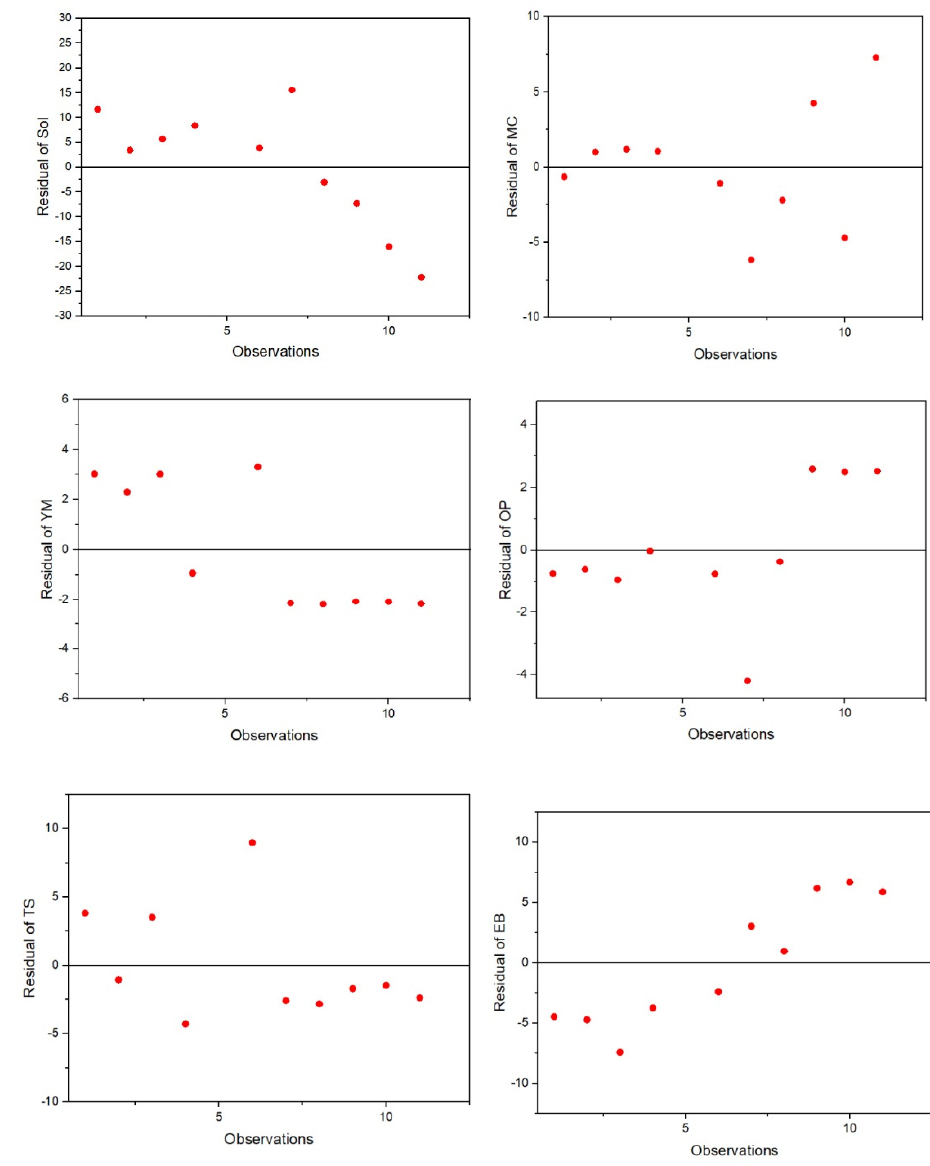
Figure 3. PLS regression residuals’ distribution for the selected dependent variables ( Sol , solubility; MC , moisture content; YM , Young Modulus; OP , opacity; TS , tensile strength; EB , elongation at break).